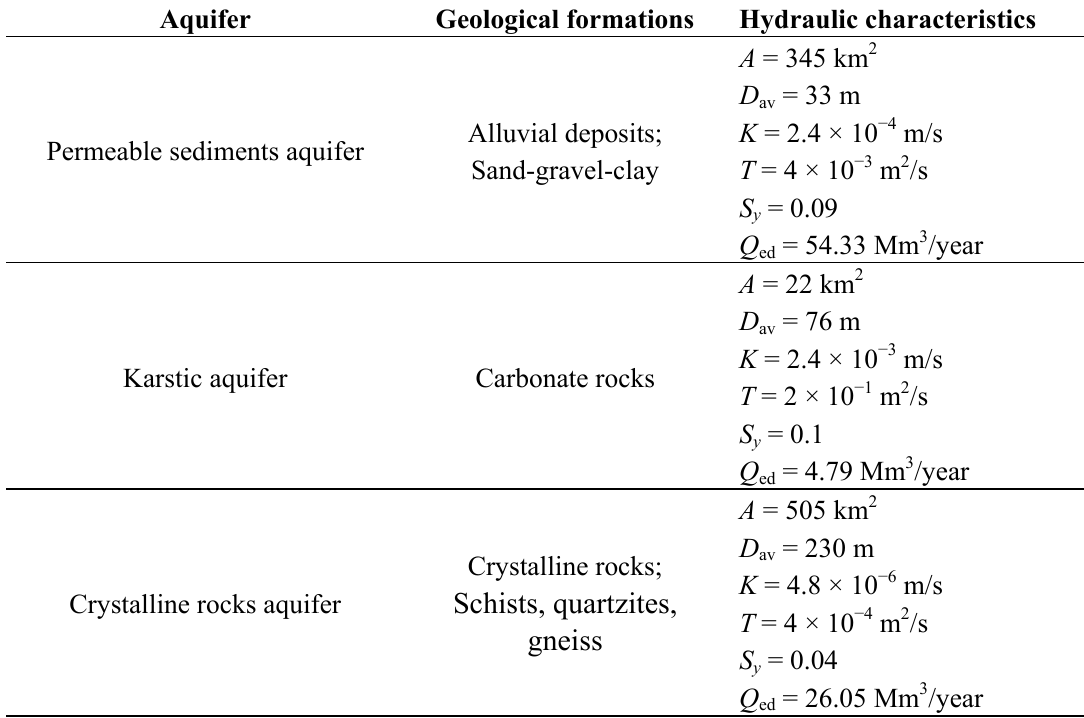
Table 3. Hydrogeological characteristics of the Gallikos River basin aquifers. (A = effective area, D = average thickness, T = average transmissivity, K = average hydraulic av conductivity, S = specific yield, Q = exploitable dynamic groundwater y ed